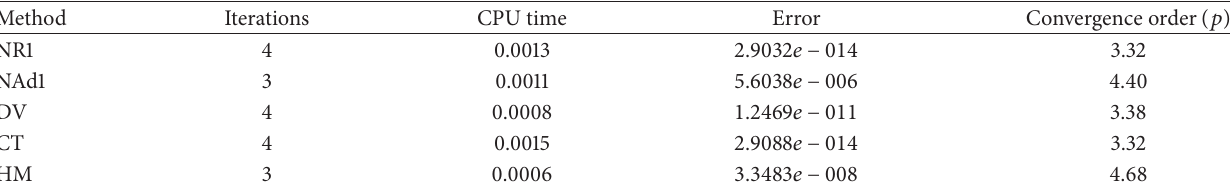
Table 4: Numerical results of Example 4 with initial value 𝑥 0 = (−1,−1, −1,−1) 𝑇 .